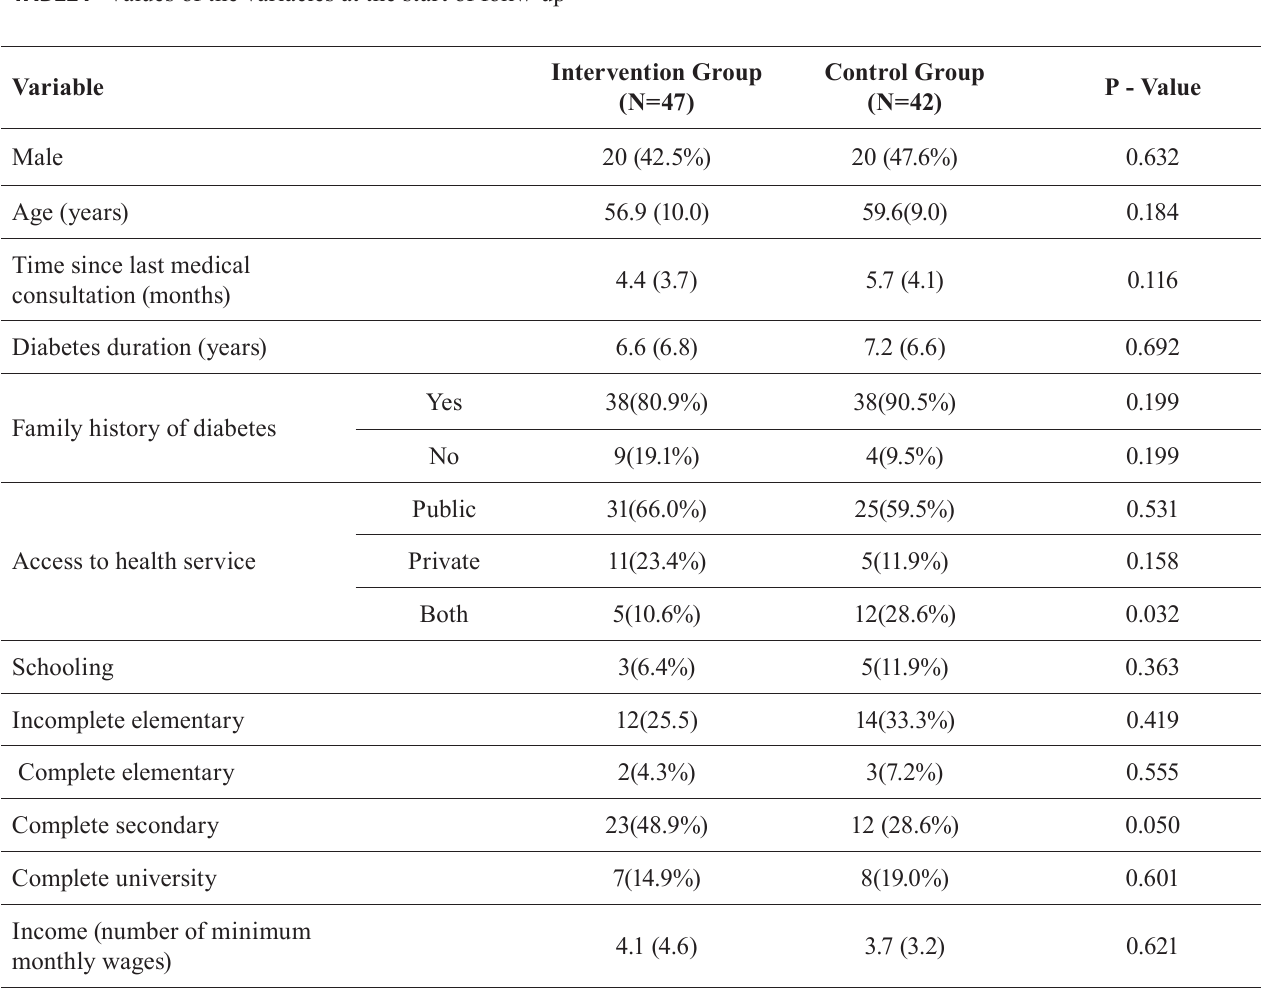
TABLE I - V alues of the variacles at the start of follw-up